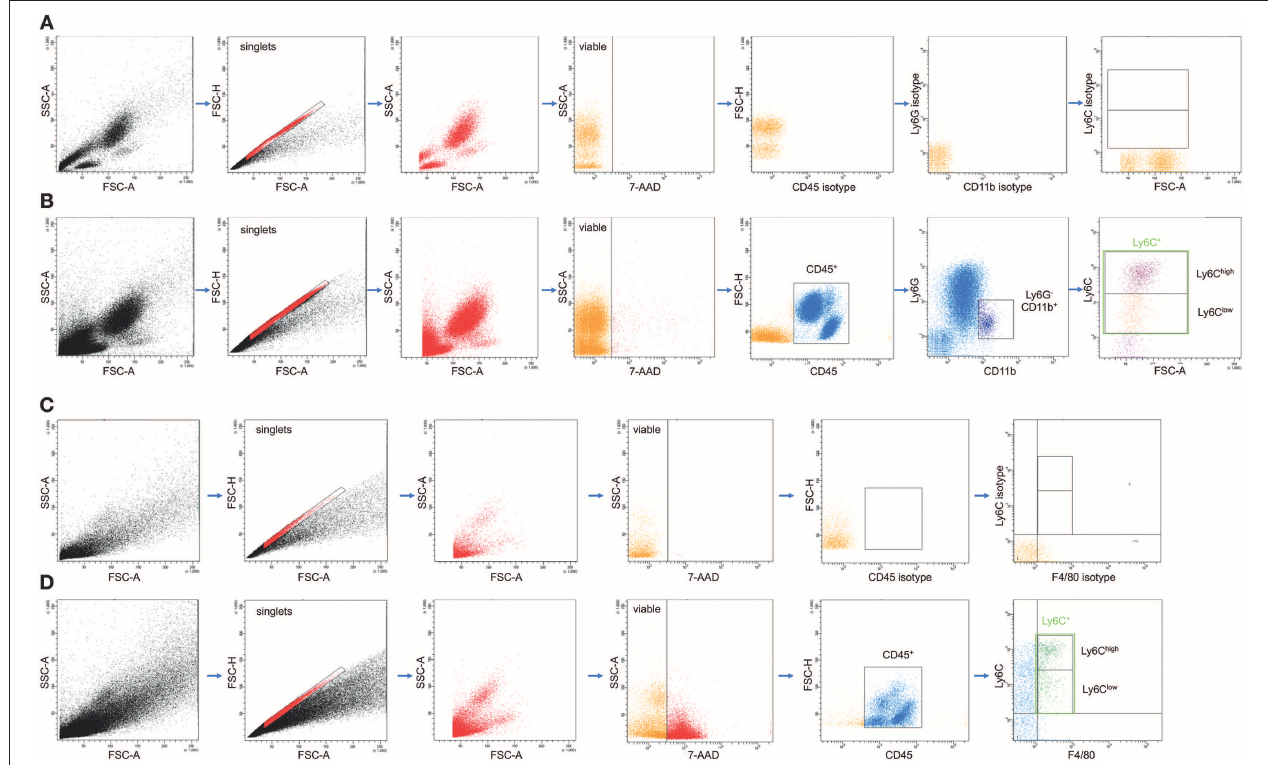
FIGURE 2 | Representative gating strategy for the flow cytometric analyses and evaluation of different monocyte subsets in whole blood (A,B) and macrophage subsets in lungs (C,D) as dot plot analyses is shown. (A,C) are showing the gating upon staining with isotype control antibodies, while (B,D) show results from the staining with specific antibodies as described in the material and method